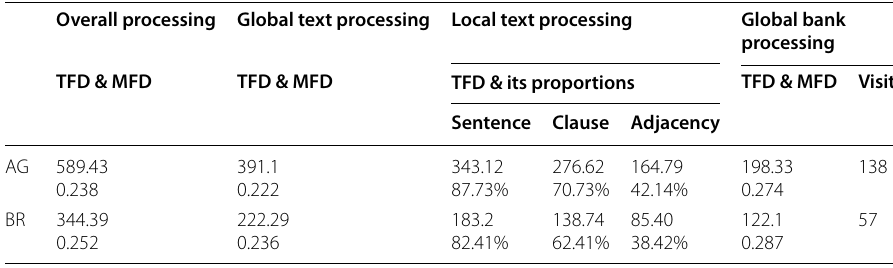
Table 7 AG’s and BR’s eye movement